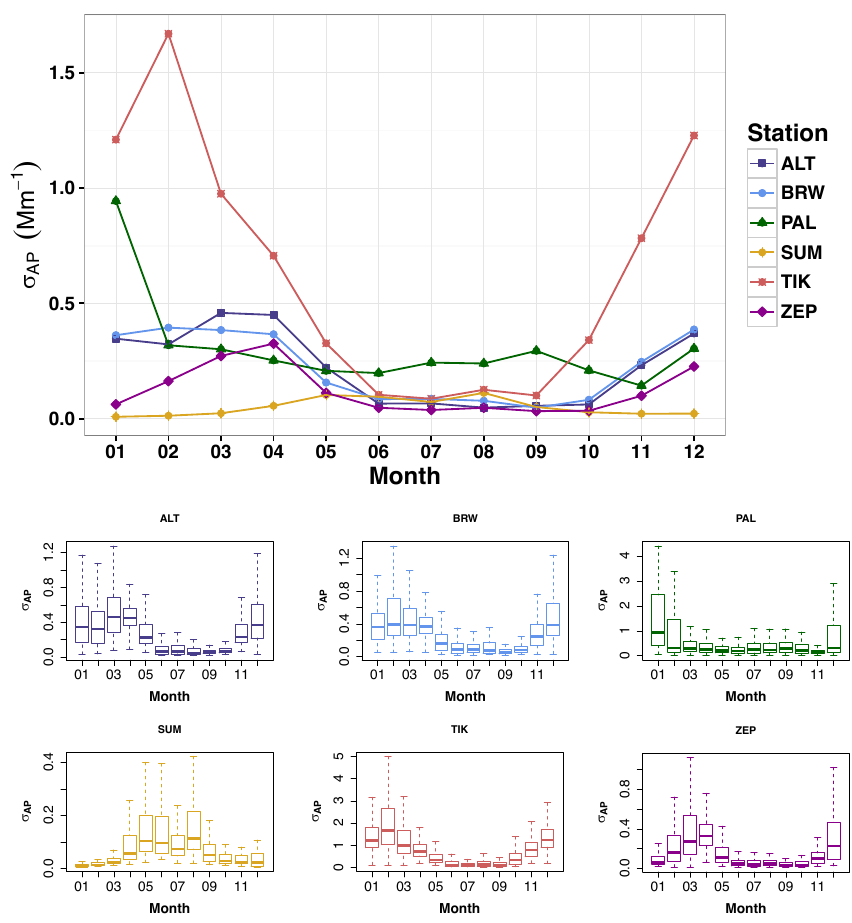
Figure 4. Seasonality of aerosol light absorption coefficient ( σ ap ) at 550nm at all sites. Large plot shows monthly medians of absorption per megameter (Mm − 1 ) at each station; subplots below show boxplots of hourly average absorption at individual sites, with horizontal line at the median, edges of the box at 25th and 75th percentiles, and whiskers at 5th and 95th percentiles. Note that y axes are different on each plot. Size cuts for the Aethalometer absorption measurements are as follows: 10µm (ALT); 2.5µm (SUM); 10µm (TIK); and no size cut at BRW, PAL, and